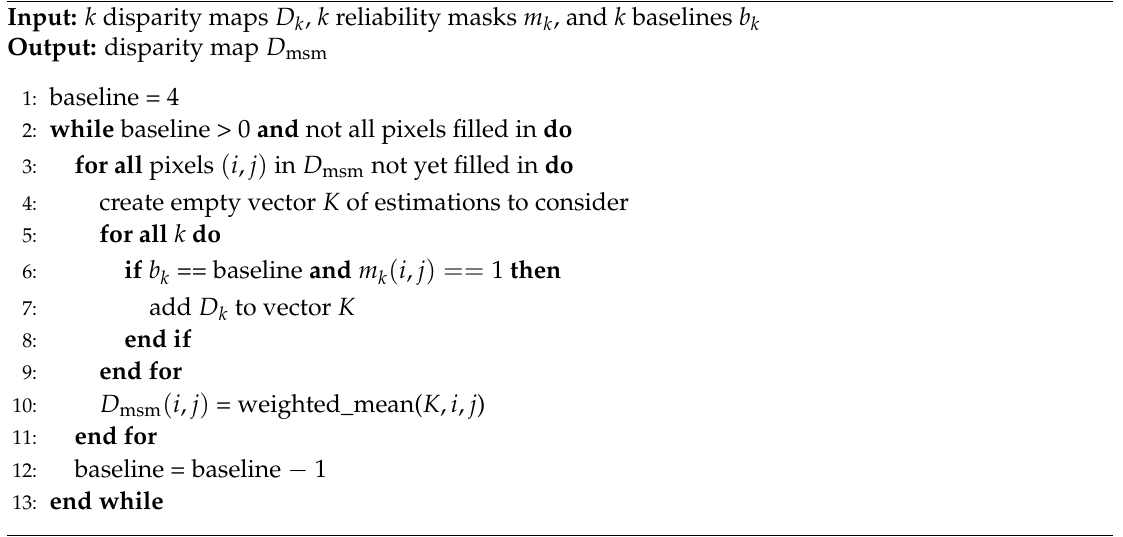
Algorithm 1 Disparity maps fusion